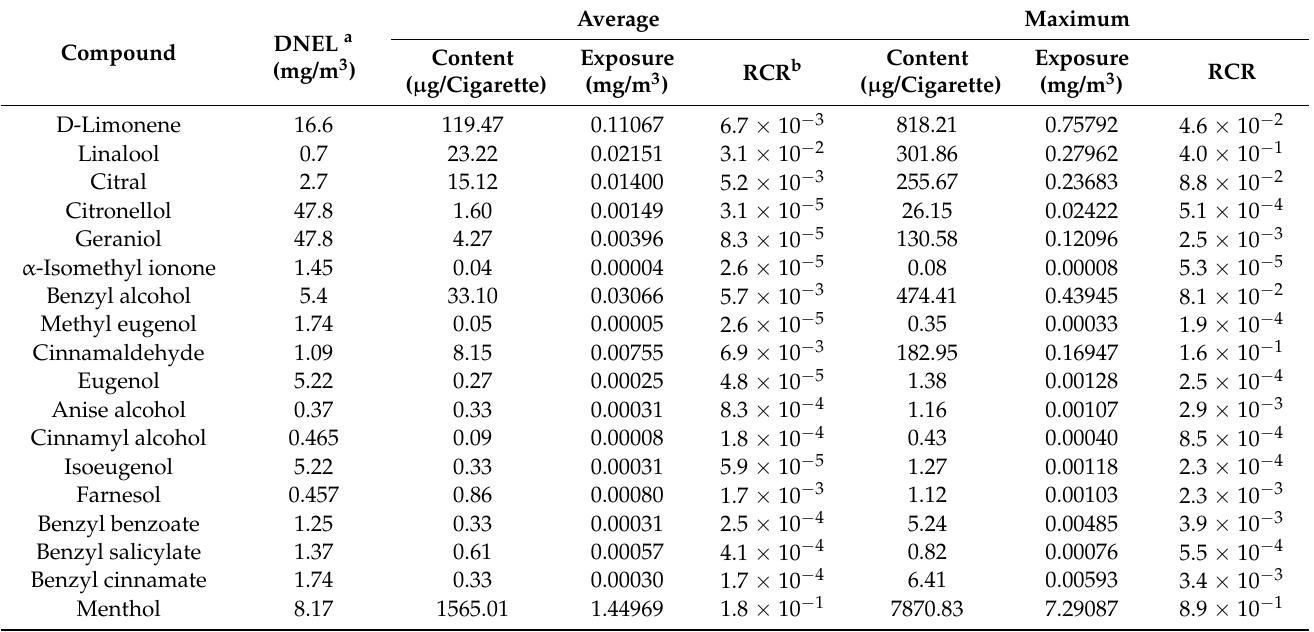
Table 5. Risk assessment of allergenic flavoring agents in flavored